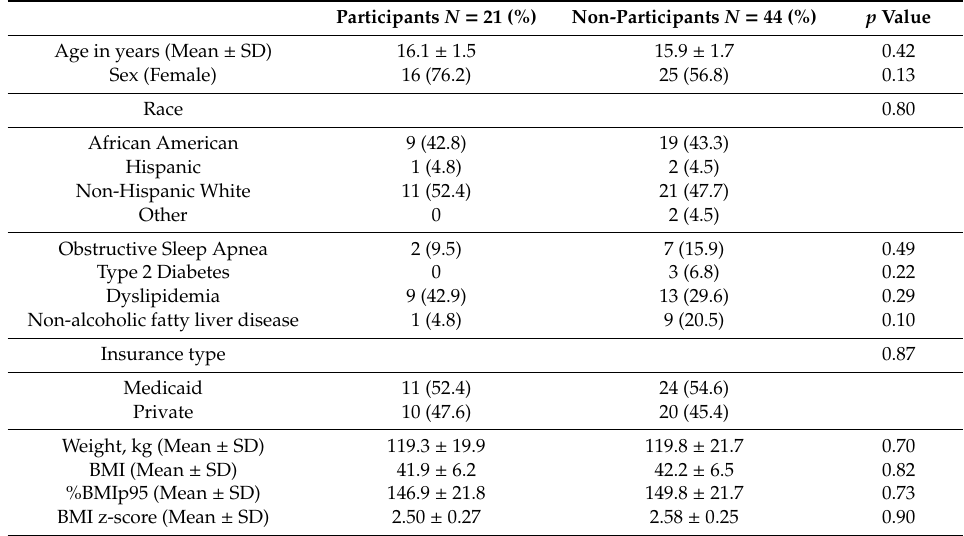
Table 1. Demographic and clinical characteristics of the rPSMF eligible